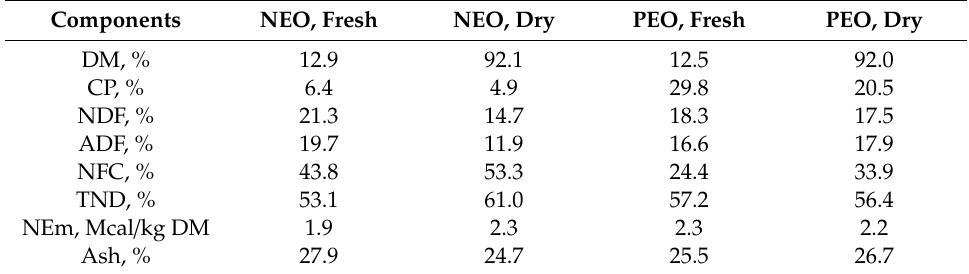
Table 1. Mean chemical composition (SD), dry-basis, of Opuntia megacantha Salm-Dyck cladodes either portein-enriched (PEO), non-protein enriched (NO), and o ff ered as supplement to adult mix-breed (Alpine-Saanen-Nubian × Criollo; n = 45) female goats exposed to testosterone treated bucks and to an increased natural photoperiod (Apr–June; anestrous season) under semiarid-subtropical rangeland conditions in Northern Mexico (25 ◦ N). Components NEO, Fresh NEO, Dry PEO, Fresh PEO,